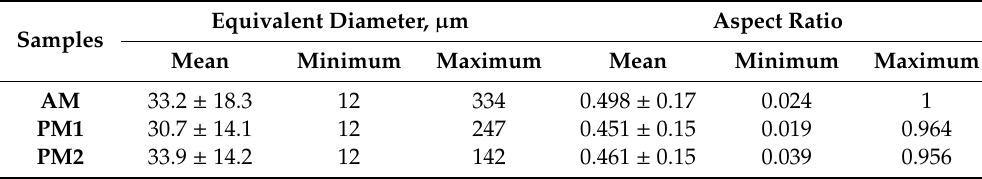
Figure 9. SEM images of internal porosity. ( A ) AM, ( B ) PM1 and ( C ) PM2.